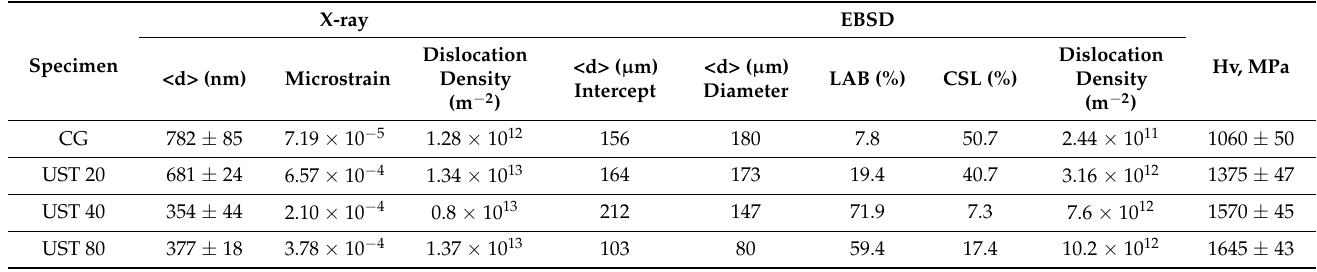
Table 1. The data of X-ray diffraction, EBSD analyses and microhardness measurements of coarse- grained nickel in the initial and post-UST states with stress amplitudes of 40, 60 and 80 MPa